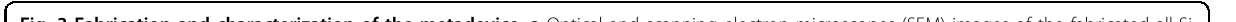
Fig. 3 Fabrication and characterization of the metadevice. a Optical and scanning electron microscopes (SEM) images of the fabricated all-Si metasurface from different angles. b The experimental measurement setup for performance characterization. Blackbody, a linear polarizer, and liquid crystal retarder are used to generate collimated and the broadband incidence with selected polarization states. A series of commercial bandpass fi lters with 50 – 250 nm bandwidths are adopted to produce monochromatic light. The mid-wavelength infrared camera captures the interfered patterns in the far- fi eld cooled at about 80 K. c The captured images at different frequencies on the same focal plane with left circular light incidence. The annular intensity distribution rotates with the incident frequency. d The intensity contrasts at different frequencies. The values are on a logarithmic scale. e The mapping relationship between the rotation angle of the interfered spots and the frequency. The analytical values are also plotted for comparison as indicated by the purple dashed line. The gray zones highlighted in ( d ) and ( e ) denote the designed operation bandwidth from 3150 nm to 4150 nm. The blue background in ( d ) and ( e ) represents the designed operation bandwidth.